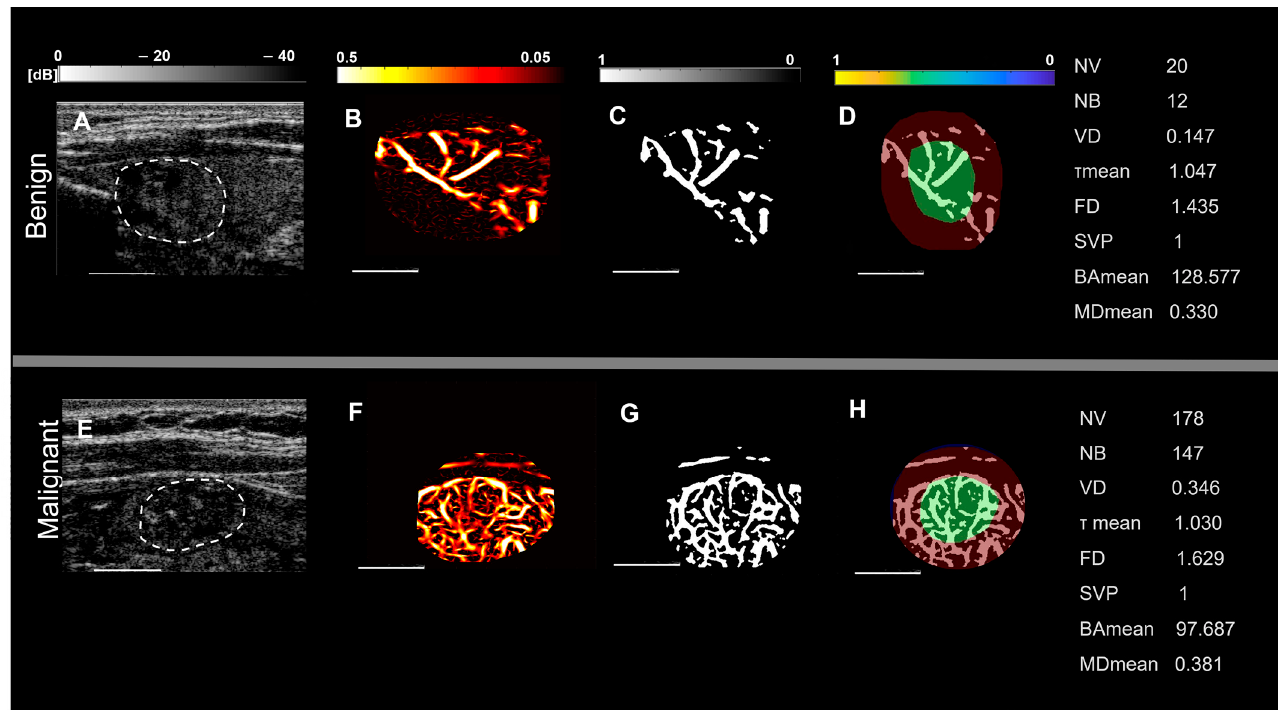
Figure 1. Representative images of large thyroid nodules > 20 mm, benign (top row) and malignant (bottom row). ( A , E ) are B-mode ultrasound images (dashed white circles delineate the boundaries of the nodules), ( B , F ) are HDMI images showing tumor microvessels, ( C , G ) are binary images of microvessels, ( D , H ) spatial vascularity pattern (SVP) diagrams (green circles represent the central region and the red ones the peripheral region of the nodule). The correspondent quantitative biomarkers are displayed on the right side of each row. The white line denotes a scale of 1 cm.